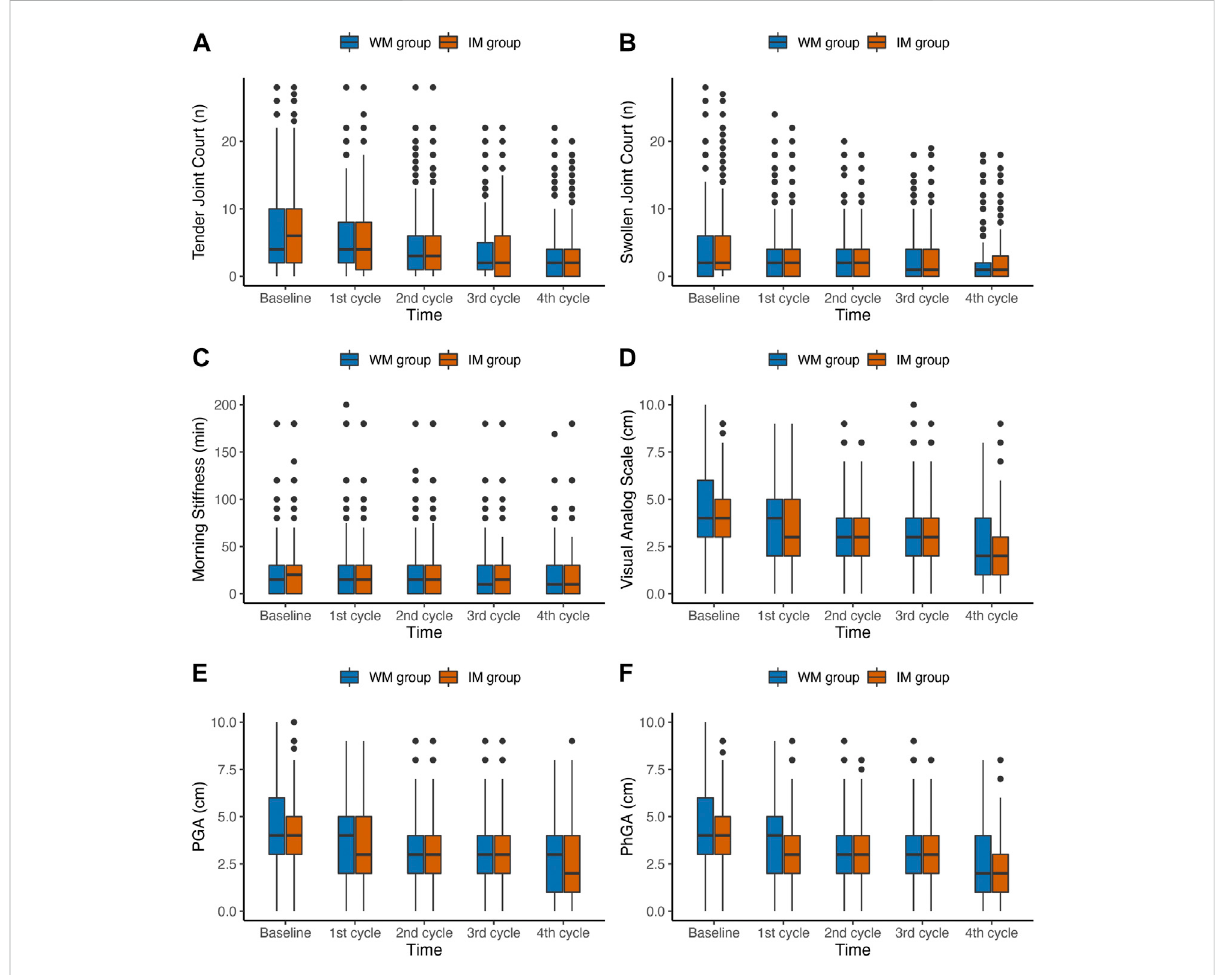
FIGURE 2 Boxplots of changes injoint,morningstiffness, andpain outcomesduring the fi rst year offollow-upinPPpopulation.